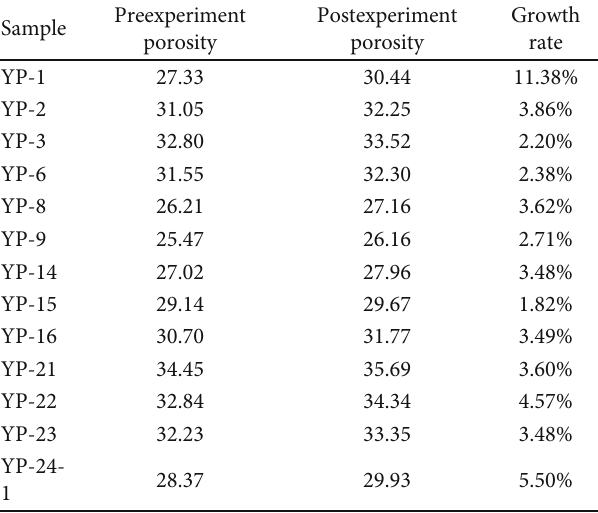
Table 6: Porosity of the samples before and after the seepage